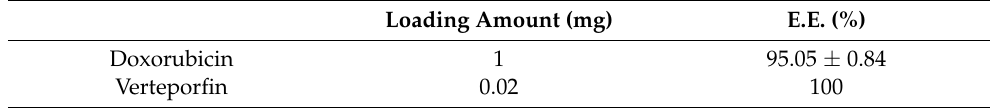
Table 1. Encapsulation efficiency of doxorubicin and verteporfin in DOX-VP-PLs.